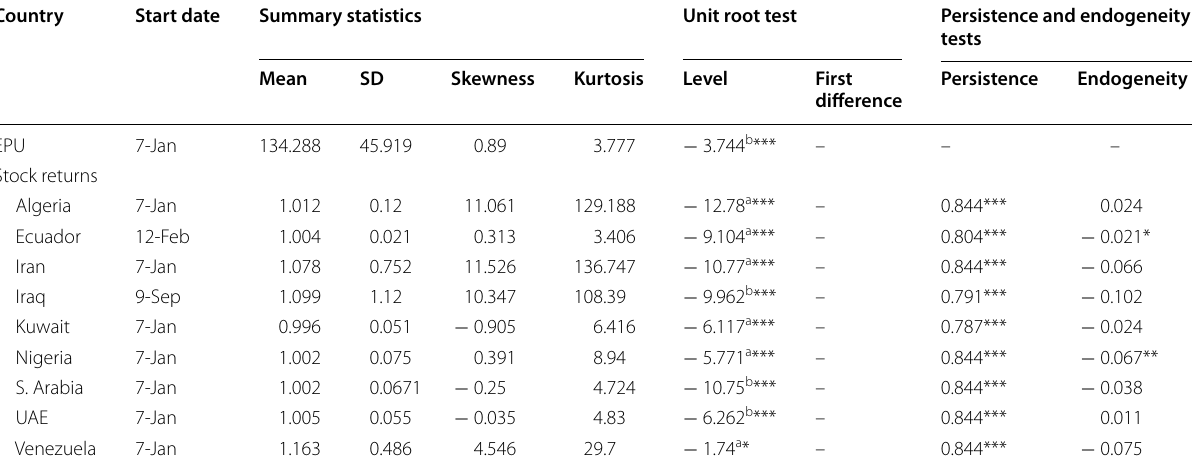
Table 1 Preliminary test